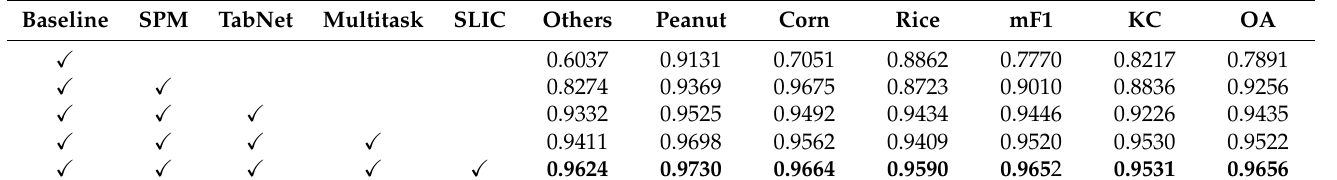
Table 6. Ablation experiments for the network design. The optimal accuracy value in each is bolded.